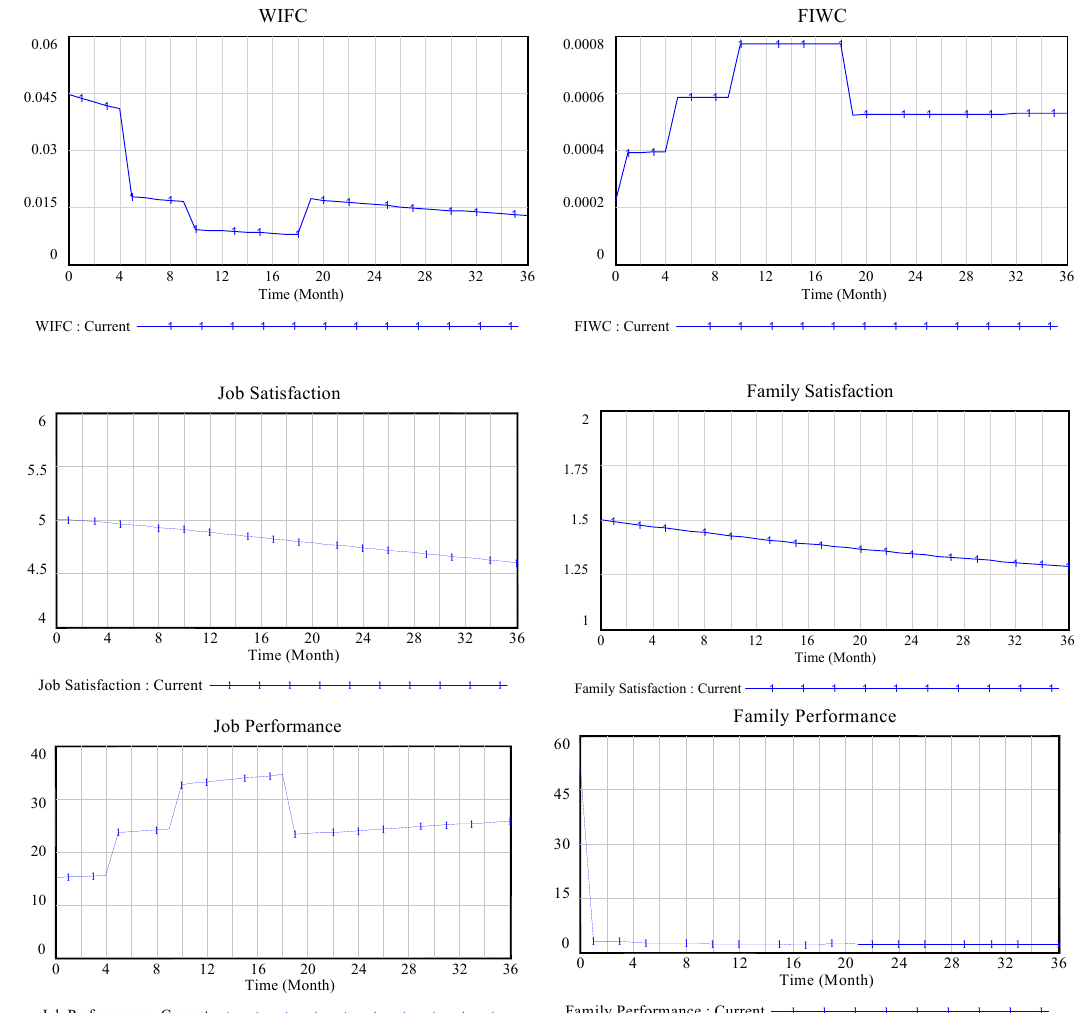
Figure 5. Simulation results under given parameters.